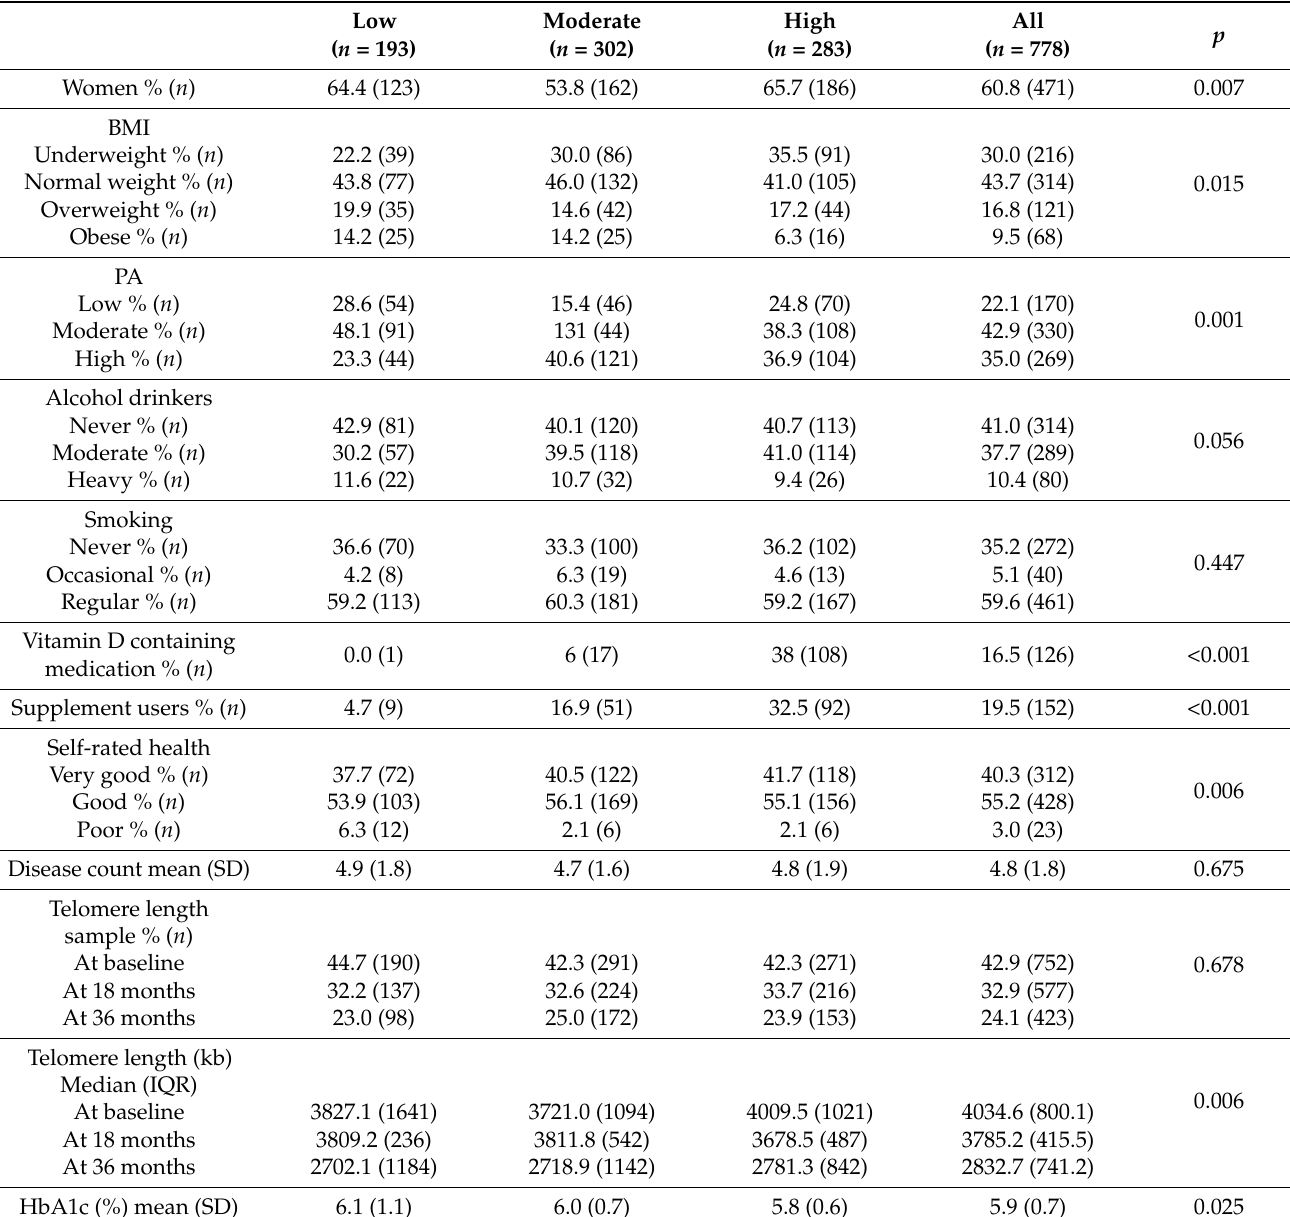
Table 1. Participant characteristics by circulating 25(OH)D cut-offs in the Newcastle 85+ Study at